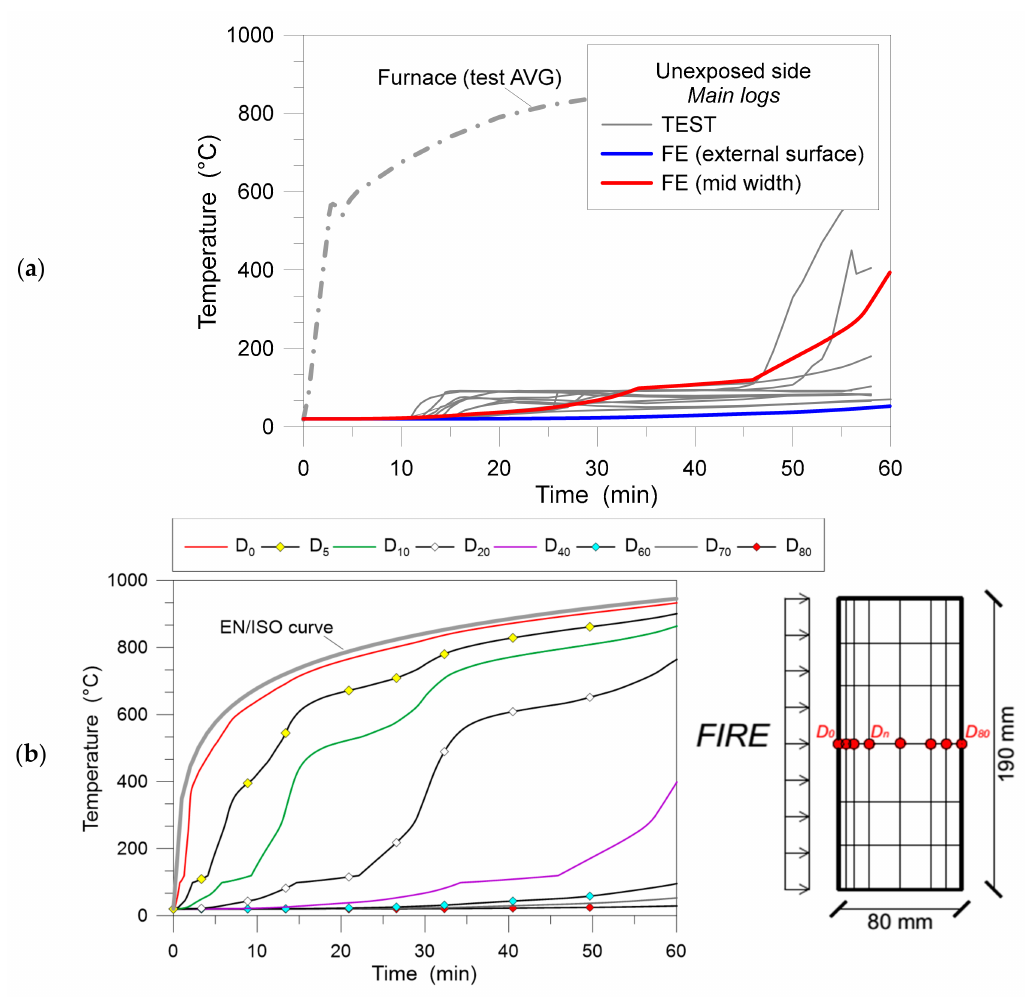
Figure 9. FE heat transfer results (ABAQUS). Numerical evolution of temperatures in the main timber logs (middle section), as observed ( a ) by comparison with test results (with grey plots representing the ecperimental temperature variation in time, on the unexposed side of the main timber logs) or ( b ) in the thickness of the